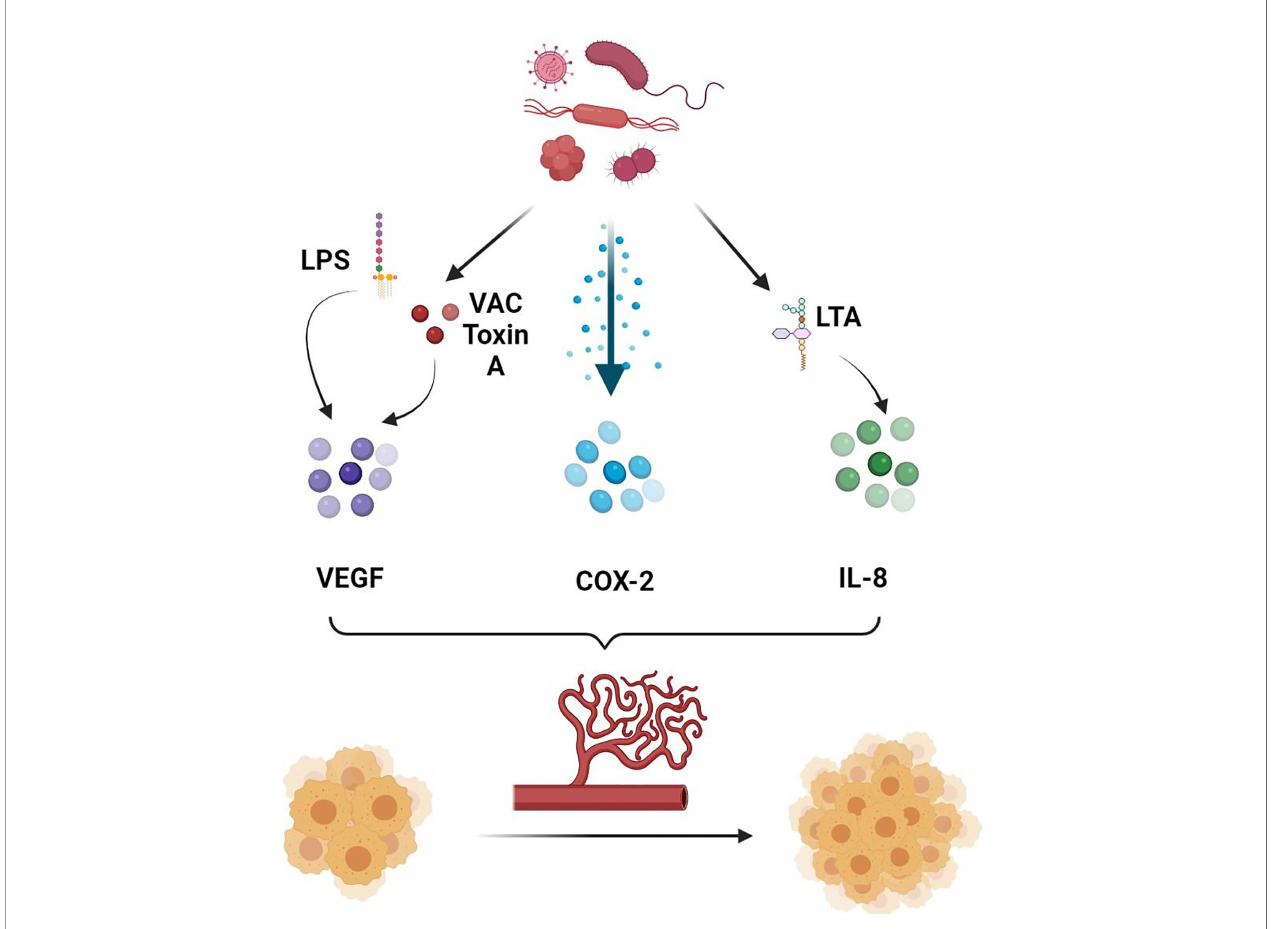
FIGURE 1 | Role of gut microbiota in promoting angiogenesis. Gut microbiota secretes several molecules and chemokines in turn can induce the production of pro- angiogenic factors, allowing increased tumor angiogenesis and consequently tumor growth and metastasis. LPS, Lipopolysaccharide; VAC Toxin A, Vacuolating Toxin A; COX-2, Cyclooxygenase 2; LTA, Lipoteichoic Acid; IL-8, Interleukin